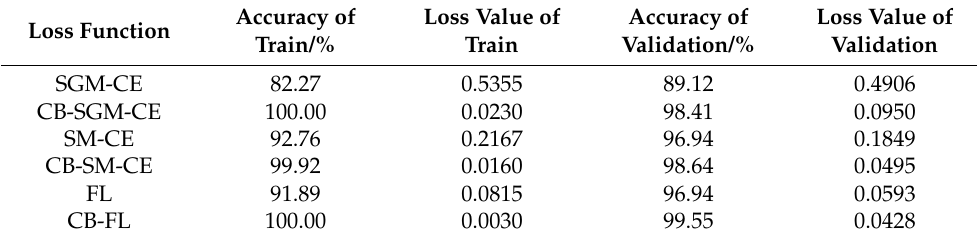
Table 1. Results of training and validation using different loss